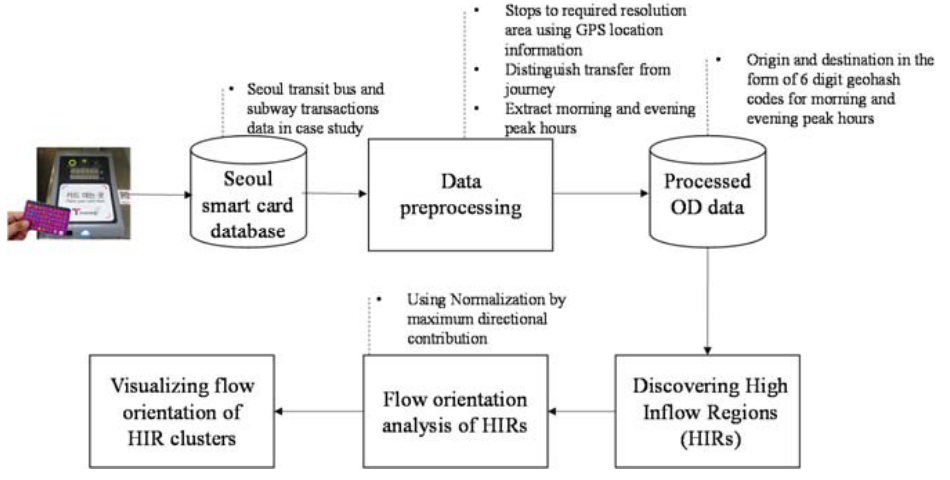
Figure 2. Flow orientation analysis of Seoul transportation data.